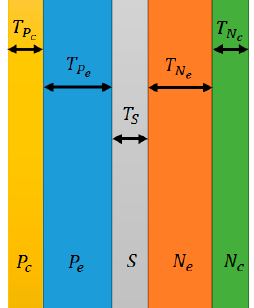
Figure 5. The lithium-ion battery cell cross-section.